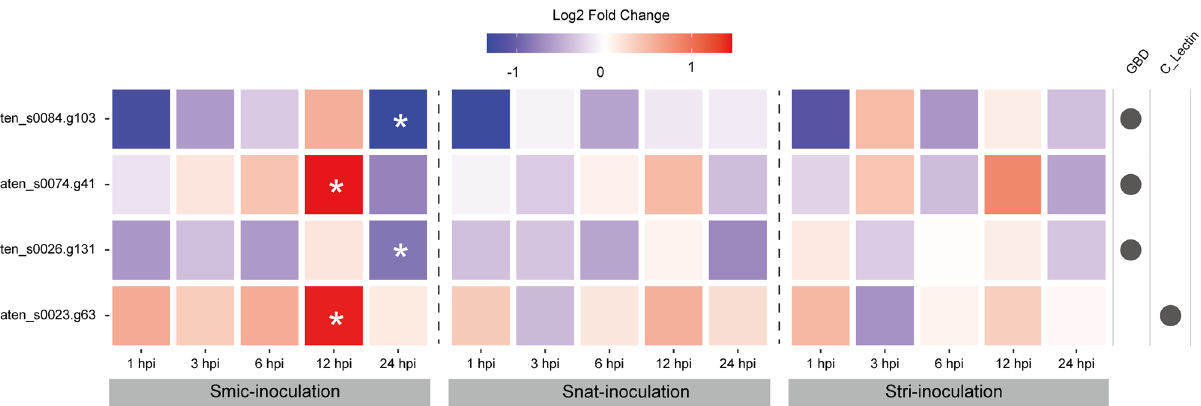
Figure 4. Expression patterns of DEGs related to pattern recognition. DEGs bearing C-type lectin-like superfamily (C_lectin) or galactose-binding domain-like superfamily (GBD) domains are shown. Gene IDs are shown on the left. Circles on the right indicate domains that the gene possesses. “Fold Change” indicates the relative gene expression level compared to controls